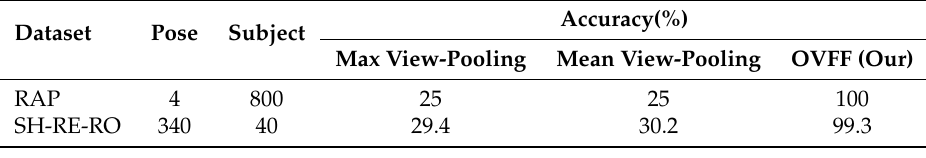
Table 3. Comparisons of our OVFF with traditional pooling layer for pose classification on the RAP and SH-RE-RO datasets.